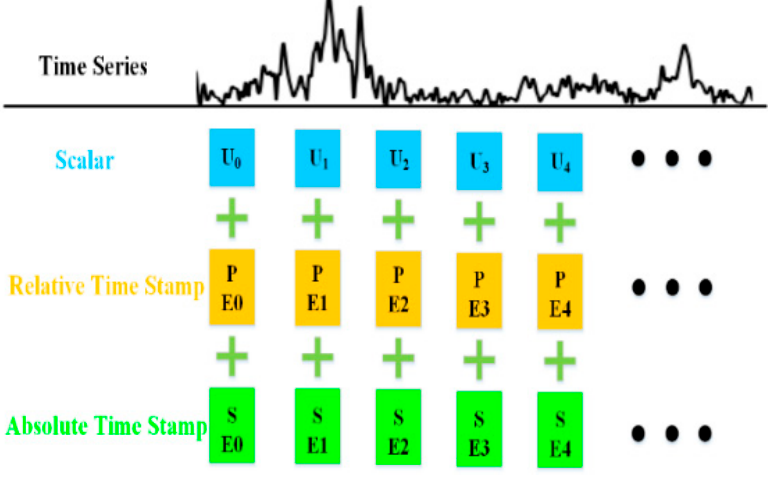
Figure 4. The embedding structure.